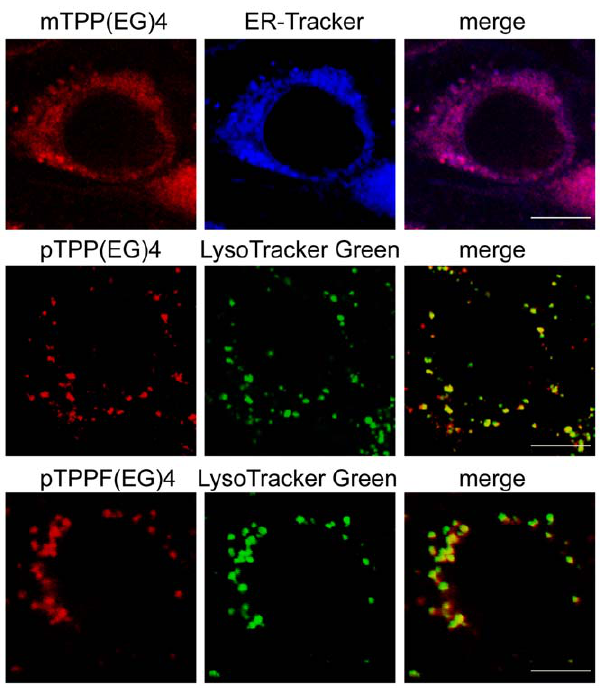
Figure 1. Subcellular localization of EG-porphyrin derivatives. 4T1 cells were loaded with EG-porphyrin derivatives (left panels) and specific probes for endoplasmic reticulum (ER) and lysosomes (middle panels). An overlay of EG-porphyrin derivatives fluorescence with ER- Tracker or LysoTracker fluorescence is shown in the right panels. Scale bars: 10 m m.